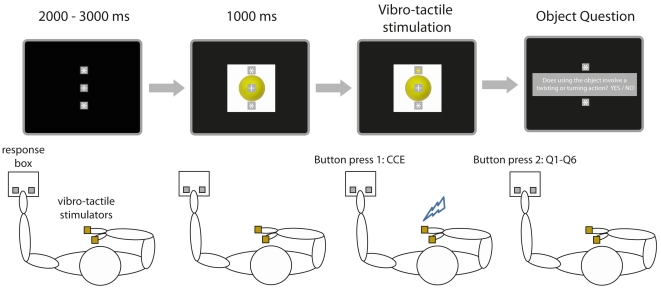
Experimental setup and procedure.Subjects were seated behind a table, facing a computer screen. Tactile vibrators were attached to the thumb and index finger of the subject's right hand and the subject responded with the left hand by pressing one of two buttons on a button box. Each trial started with a fixation cross (1st panel from left), followed by the presentation of an object picture (e.g. a tennis ball; 2nd panel from left), visual distractor and tactile stimulation (3rd panel from left) and an object question (right panel). Subjects responded by indicating whether the thumb or index finger was stimulated (Button press 1) and by answering a question about the object (Button press 2).